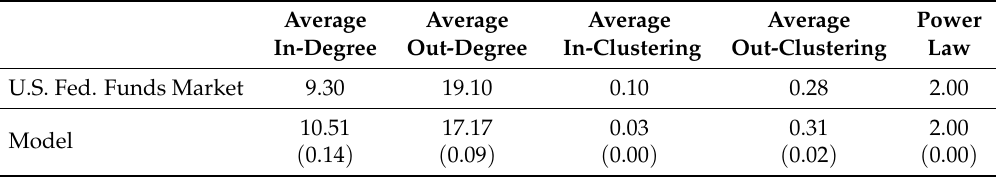
Table 6. U.S. Federal funds market interbank network property comparison (100 simulations).